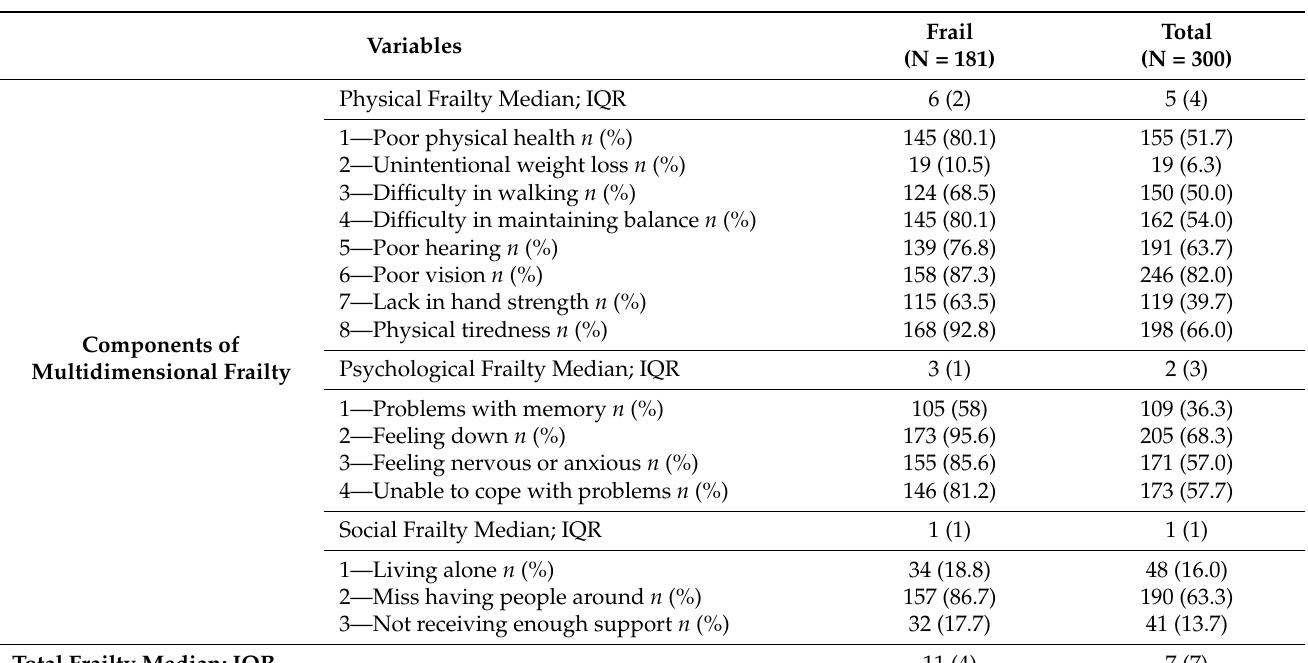
Table 2. Characterization of physical, psychological, social, and total frailty of the entire sample and the frail older adults using the TFI.